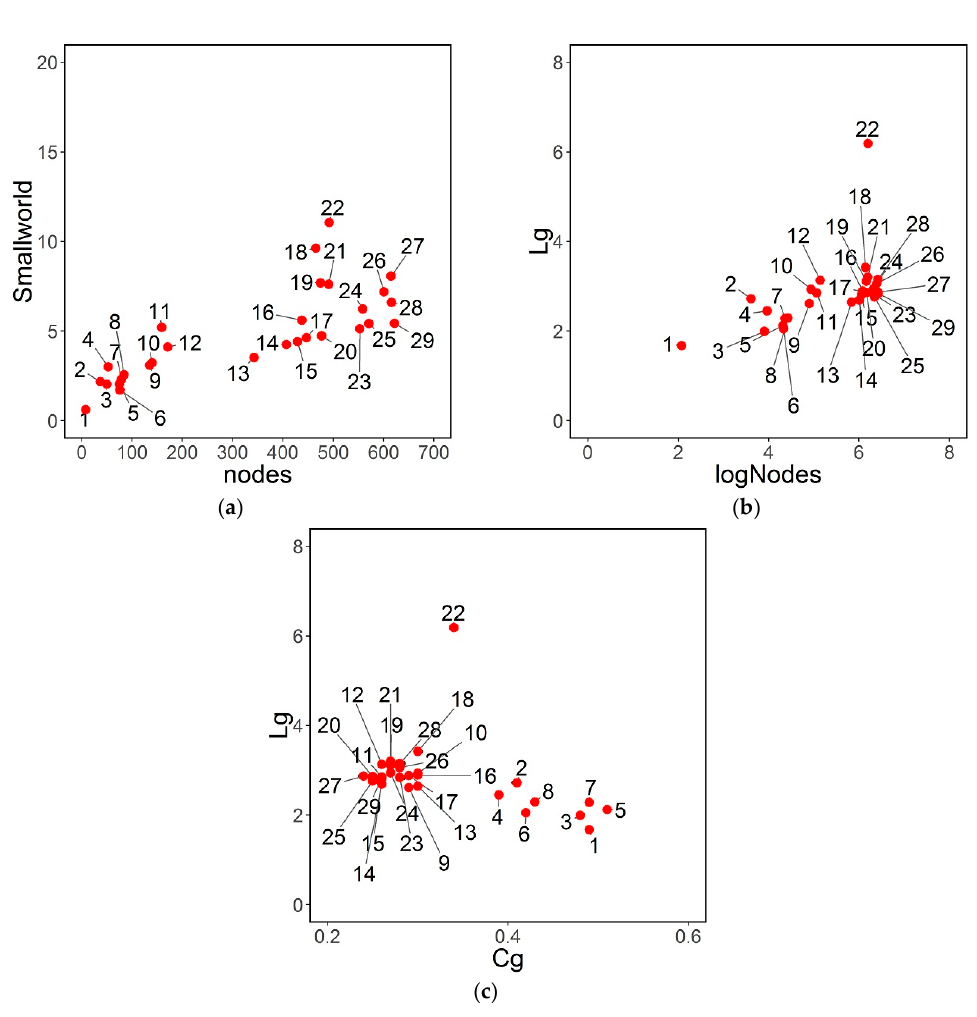
Figure 3. ( a ) Relationship between small-world-ness coefficient and number of nodes, ( b ) Relationship between shortest path and number of nodes, ( c ) Relationship between Lg and Cg. Table 3. Small-world characteristics. Faculties ordered by small-world coefficient.